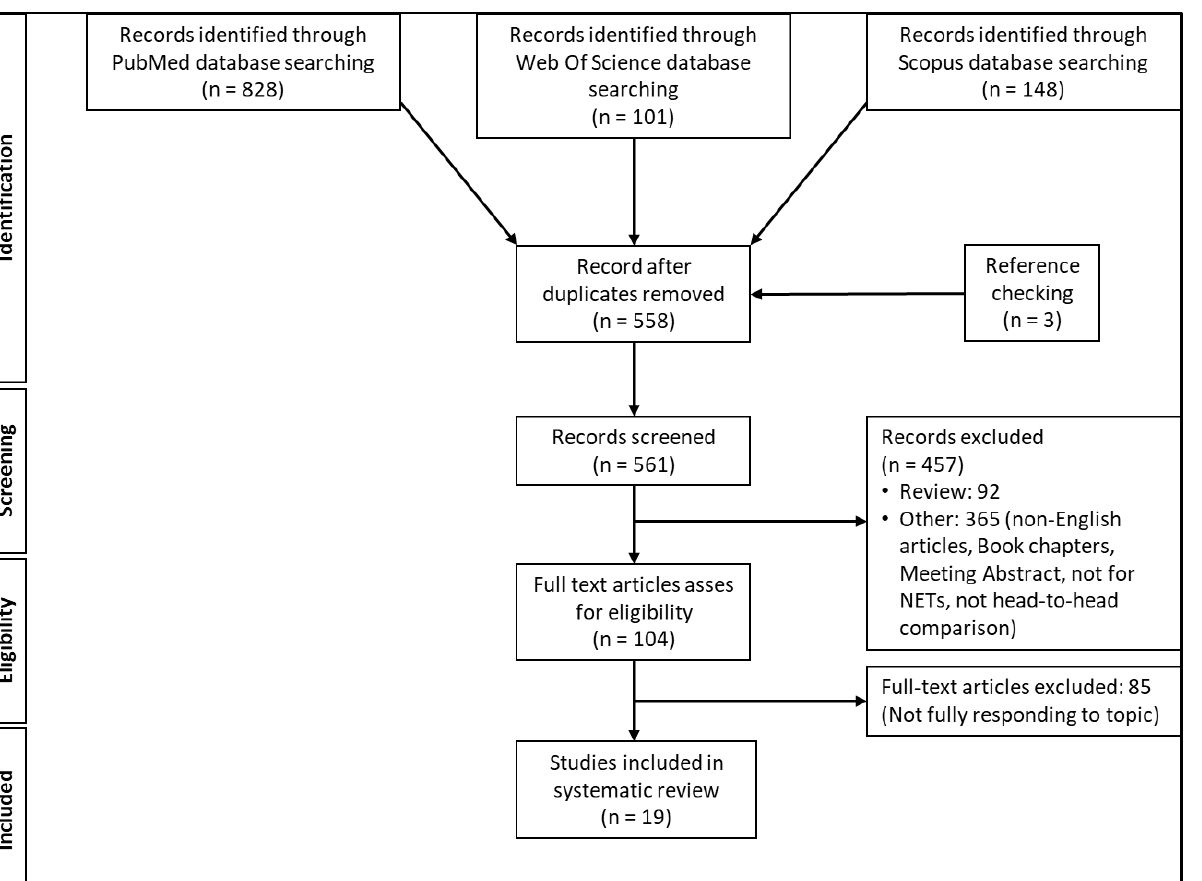
Figure 1. Scheme of record selection.